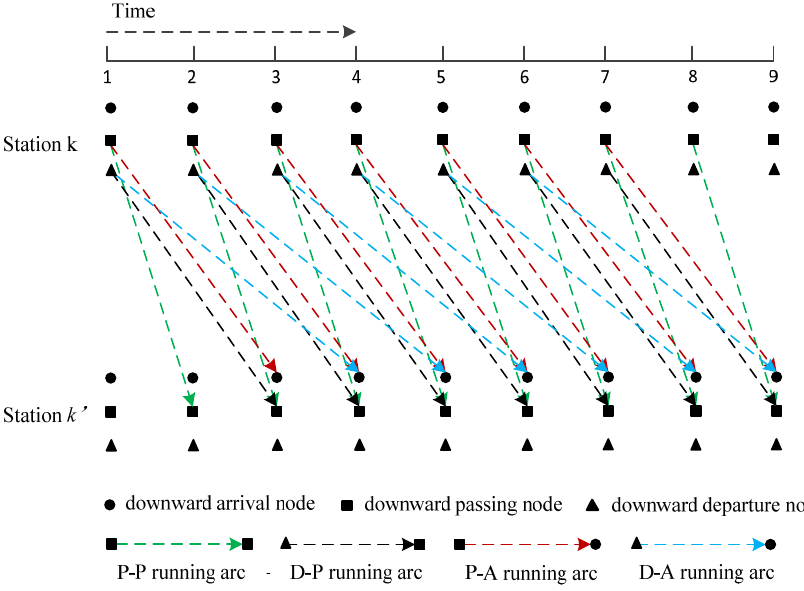
Figure 2 by the blue dotted line with arrows. In addition, t (cid:48) = t + t k , k (cid:48) + t b + t s .